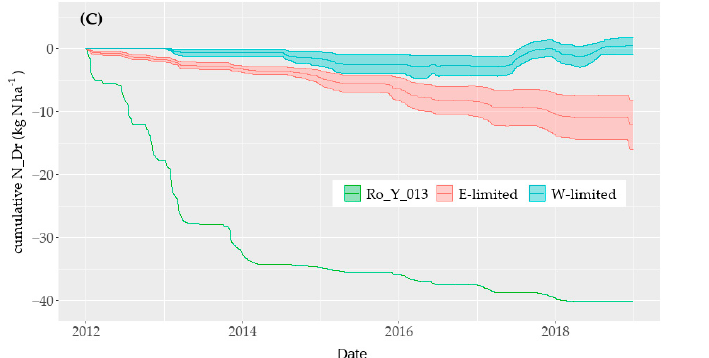
Figure 3. For the period between 2012 and 2018 in Selhausen, the water-limited site (W-limited) and Rollesbroich, the energy-limited site (E-limited), ( A ) daily precipitation (Prec) and actual evapotranspiration (ETa), ( B ) cumulative net drainage (Dr), ( C ) cumulative net leached nitrogen (N_Dr). For (B) and (C), the colored areas represent the standard deviation to the mean value of each study site. For (C), because E-limited Ro_Y_013 behaved differently compared with the other E-limited lysimeters, its dataset is presented separately. For the Budyko plots, the average values of AI and EI were 0.65 and 0.59 for E-limited and 1.04 and 0.88 for W-limited, respectively. According to the Budyko framework, water